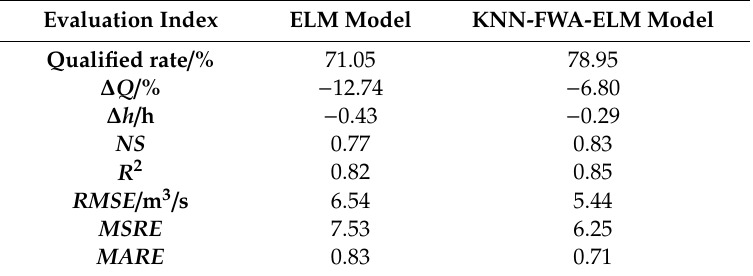
Table 9. Comparison of small flood simulation